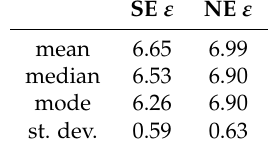
Table 4. Summary of dielectric constant in the stronger southeast (SE) and weaker northeast (NE) leg. SE ε NE